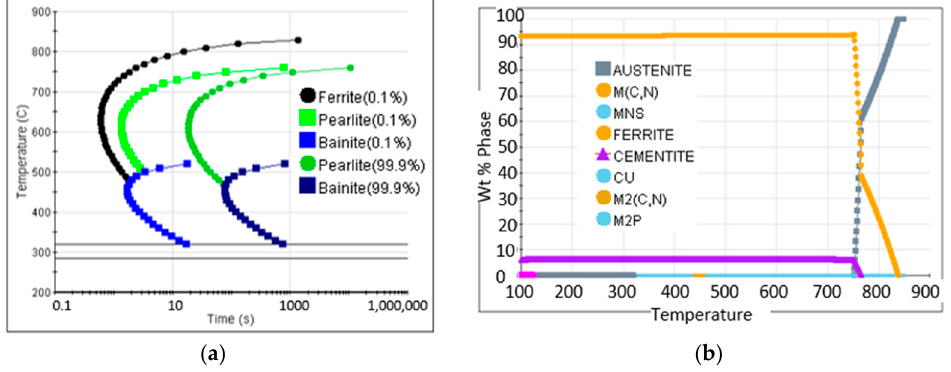
Figure 1. ( a ) Time temperature transformation (TTT) diagram for heating temperature of 850 °C and ( b ) phase development diagram for 42SiMn steel calculated in JMatPro software.